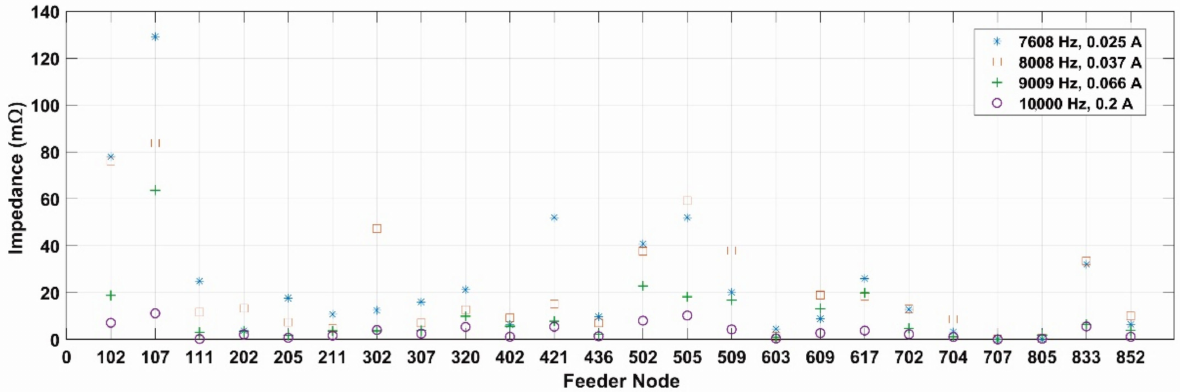
Figure 10. Transfer Impedance at different nodes of the MV network for supraharmonic current